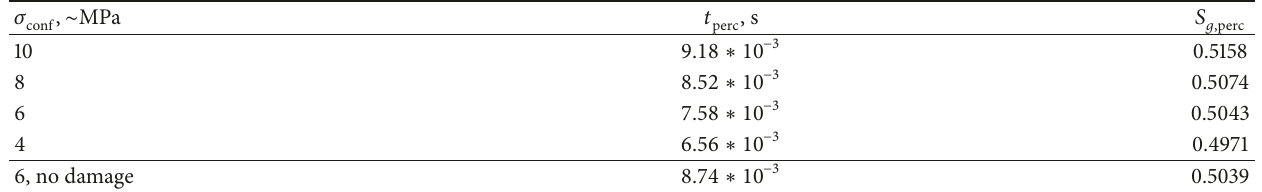
and gas saturation 𝑆 𝑔, perc